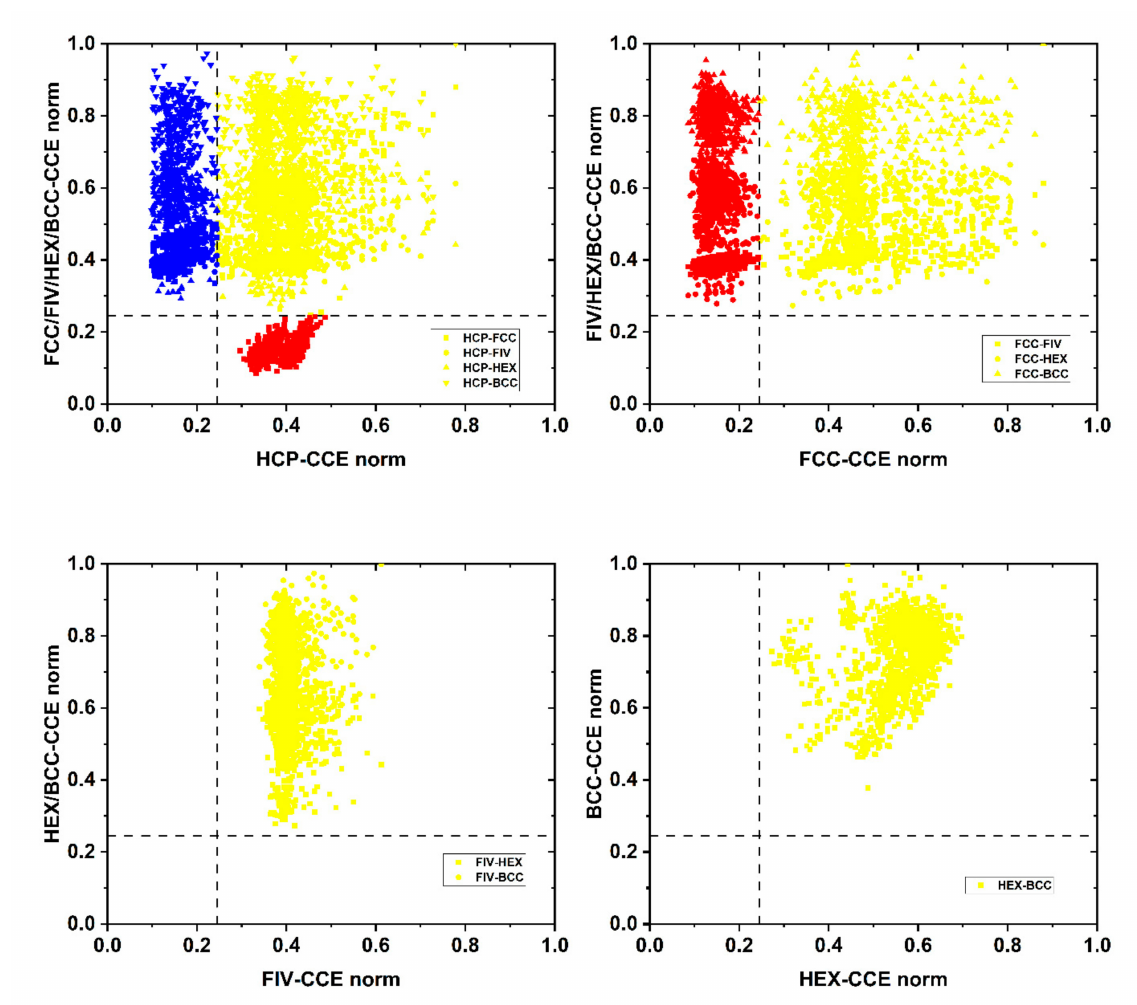
Figure 10. All possible combinations of parity plots X - vs. Y -CCE norm ( X (cid:44) Y ) for the final configuration of NPT MC simulations on a system of N at = 1200 monomers interacting with the square well potential ( ε SW = 2.1 and σ 2 = 1.2). Top-left: X = HCP and Y = FCC / FIV / HEX / BCC; Top-right: X = FCC and Y = FIV / HEX / BCC; Bottom-left: X = FIV and Y = HEX / BCC; Bottom-right: X = HEX and Y = BCC. Vertical and horizontal dashed lines denote the CCE norm threshold below which a site is labeled as X - and Y -like, respectively. Blue, red, green, purple, cyan and yellow colors correspond to HCP-, FCC-, FIV-, HEX-, BCC-like and amorphous (or unidentified) sites,